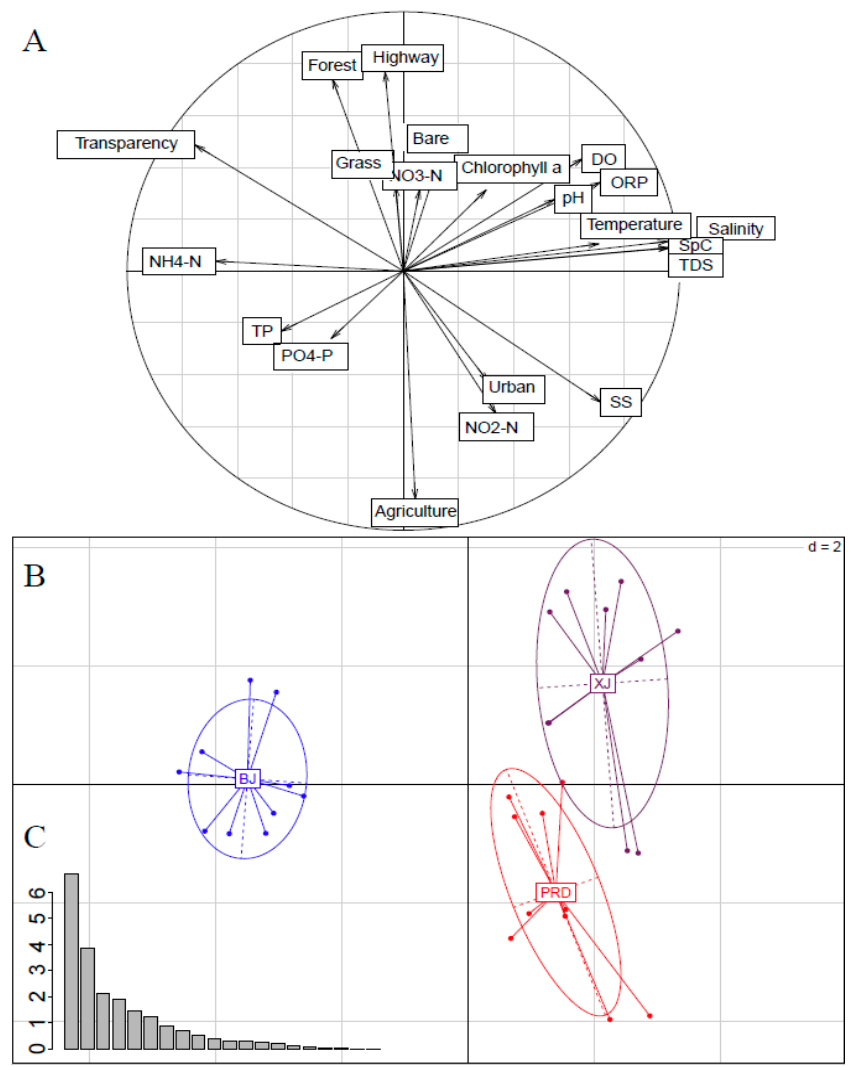
Figure 2. Principal component analysis (PCA) results for environmental variables in the Pearl River. ( A ) Vector plot indicating correlations among environmental variables and their scores on axis 1 and 2. ( B ) Multivariate analyses of environmental variables using a scatter diagram, with each tributary presented as an ellipsoid. ( C ) Bar plot showing eigenvalues in PCA. BJ, Beijiang; XJ, Xijiang; and PRD, Pearl River Delta. The abbreviations of environmental variables are defined in Materials and Methods.